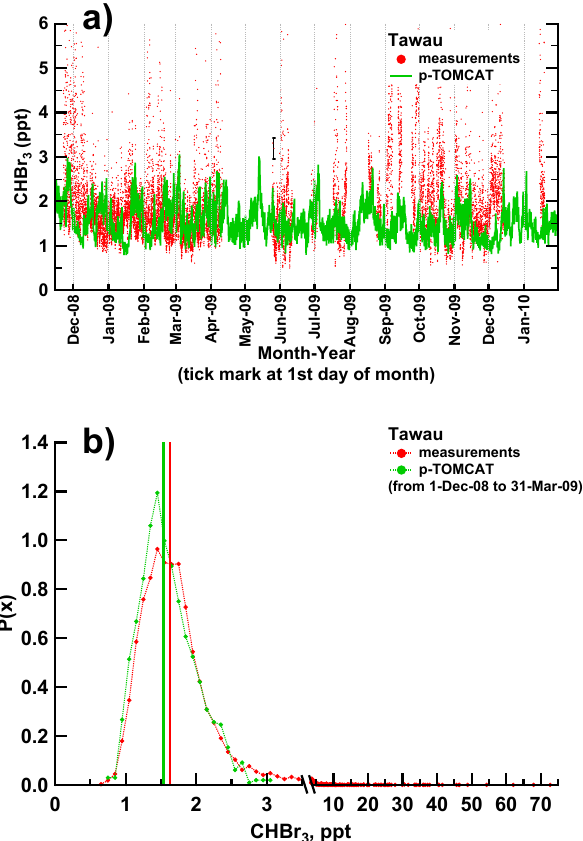
Figure 7. Time series (a) of observed (red dots) and p-TOMCAT- modelled (green line) CHBr 3 at Tawau and probability distributions (b) for observed (red circles with red dotted line) and modelled CHBr 3 (green circles with green dotted line) for December 2008 to March 2009. The black vertical error bar in ( a ) during May 2009 shows the typical CHBr 3 measurement precision ( ± 1 SD) for the whole observational period. Median CHBr 3 mixing ratios are in- dicated (b) by the red solid line for the observations and by the green solid line for the model. The model compares well overall with the observations, though there are periods when the model un- derestimates the observations (e.g. October 2009). The model does not capture the full variability of the observations which is expected given the model resolution and the uniform distribution of coastal emissions in the model; this is illustrated by the absence of the high tail in the modelled CHBr 3 (b)